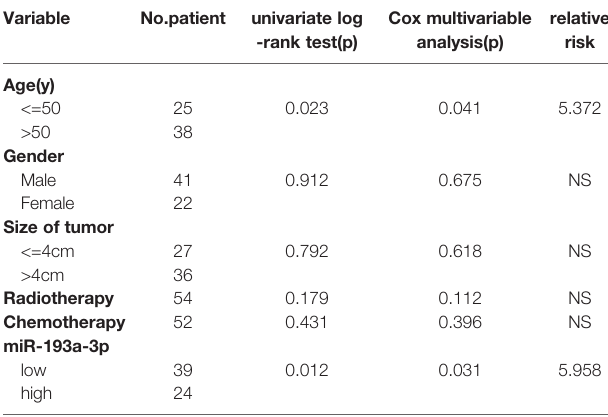
TABLE 2 | Univariate and multivariate analysis of different prognostic parameters in patients with glioblastomas by Cox regression analysis.